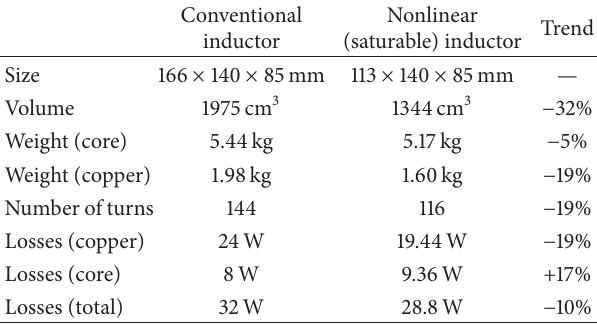
Table 1: Comparison between conventional and nonlinear (sat- urable)